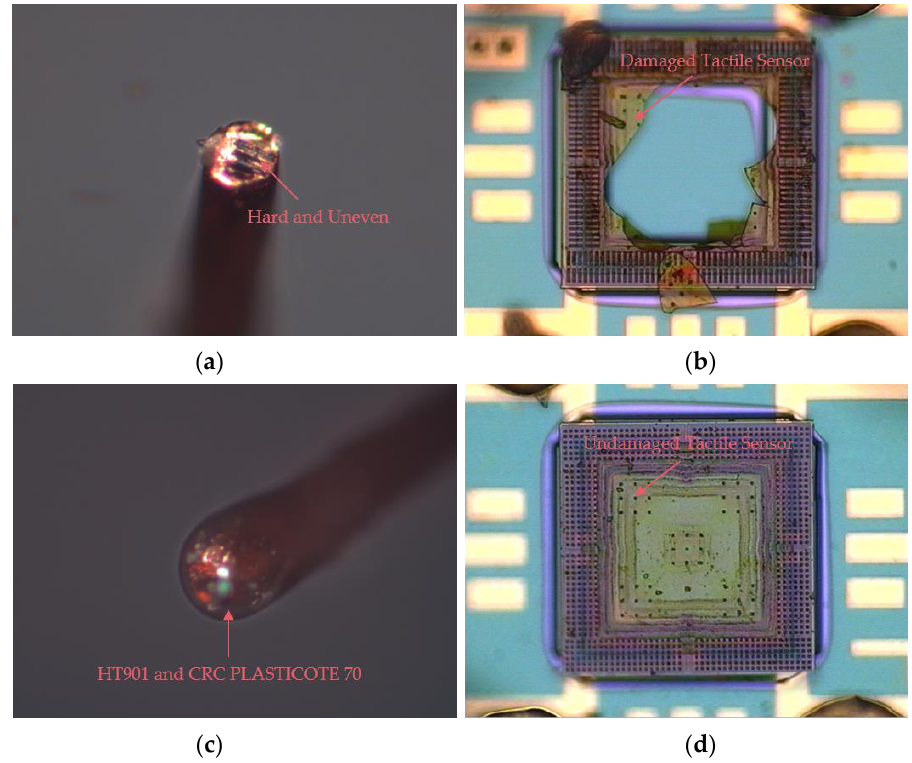
13 of 18 Figure 13. Schematic of the measurement principle of beam-shaped copper wire weights. As the tip of the copper wire weight is hard and uneven, which will damage the 1.2 μm-thick silicon nitride diaphragm of the tactile sensor when the copper wire weight is placed on the silicon nitride diaphragm, the surface of the copper wire weight is wrapped